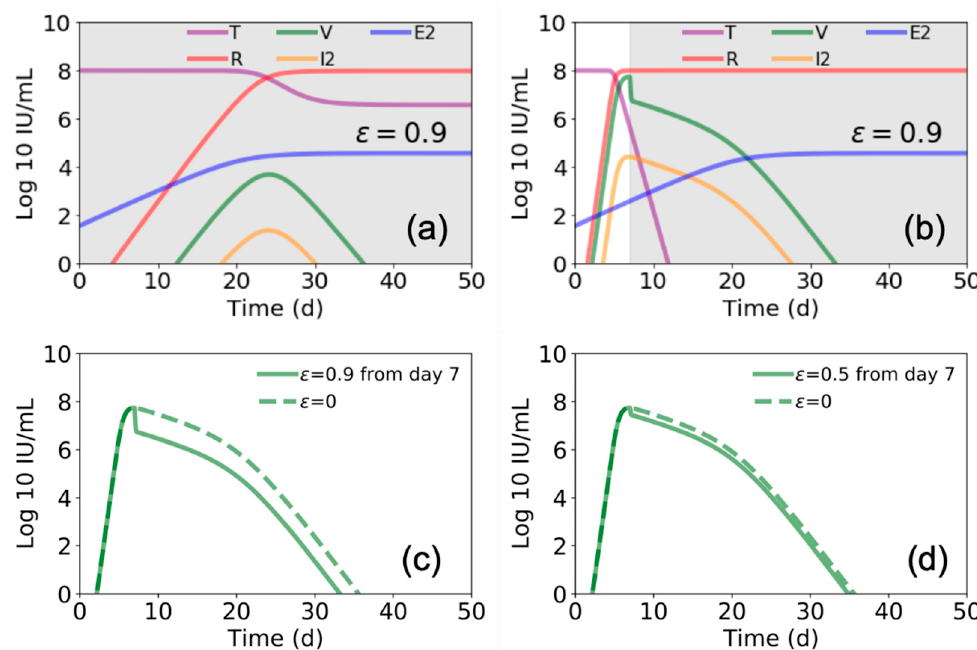
Figure 4. Estimated Ebola virus–host dynamics with antiviral treatment for different periods. In ( a ) and ( b ) we again use the parameter values presented in Figure 3 and Table 1 [4], and plot the values of target cells (T), viral load (V), refractory cells (R), productive infected cells (I2), and EBOV specific T cells (E2). In ( a ) we show this for treatment ε = 0.9 beginning at day 0 and continuing through day 50, while in ( b ) we show for treatment beginning at day 7 and continuing through day 50 (gray shaded areas indicate duration of antiviral treatment). In ( c , d ) we compare the viral load for the case of starting treatment at day 5 and continuing through day 50 for ( c ) ε = 0.9 and ( d ) ε = 0.5.